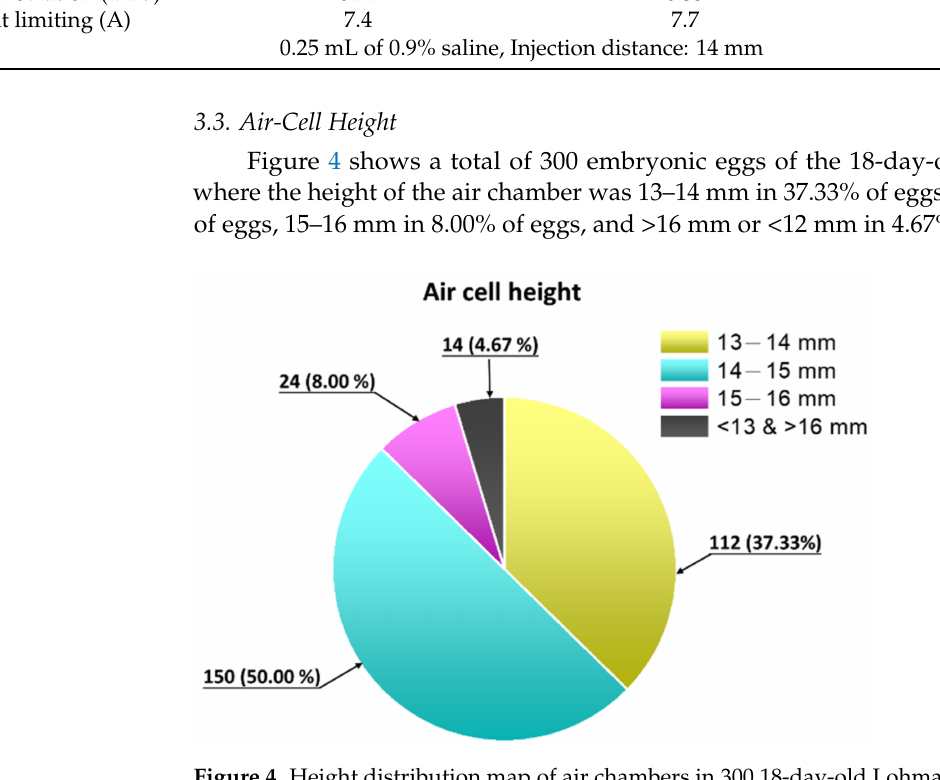
Figure 4. Height distribution map of air chambers in 300 18-day-old Lohmann eggs.